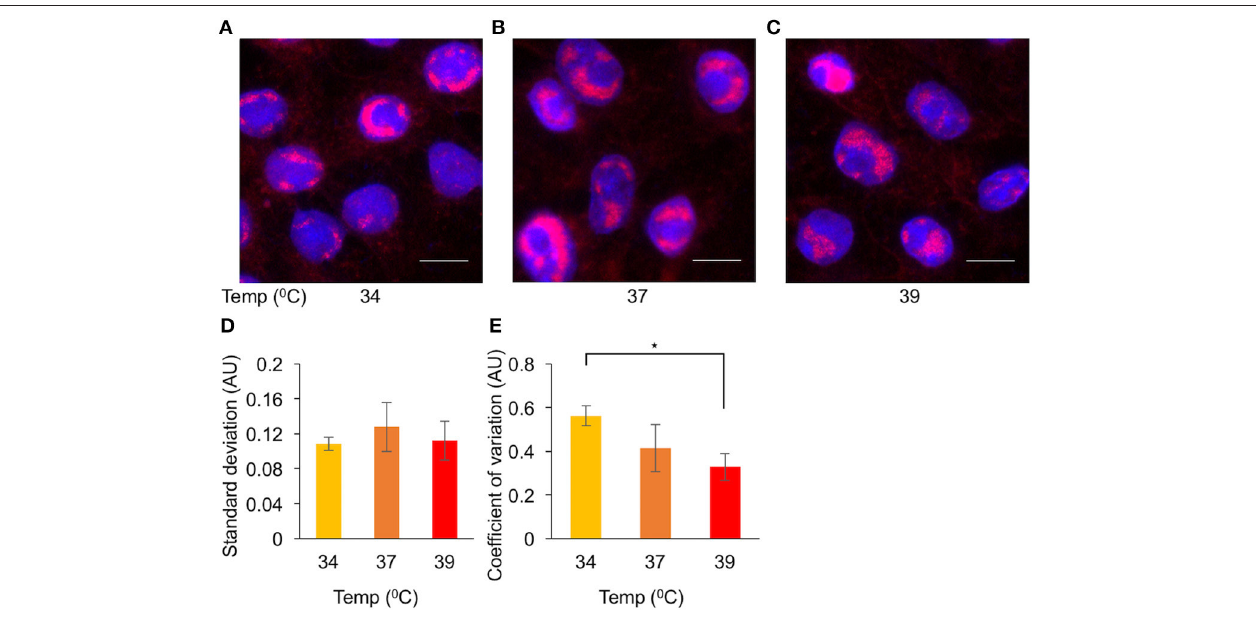
FIGURE 6 | Elevated temperature reduces cell-to-cell variability in replication compartments size. Cells were infected with OK11 recombinant virus at MOI 20. Four HPI the cells were fixed and processed for FISH. Representative images of infection at 34 ◦ C (A) , 37 ◦ C (B), and 39 ◦ C (C) are shown. Nuclei are colored with Hoechst stain in blue, viral DNA in red. Scale bar 10 µ m. (D,E) A noise comparison between the relative size of viral RCs at different temperatures, (as indicated) was performed. (D) The standard deviation and (E) the coefficient of variation (standard deviation divided by the mean) were compared. Error bars represent the standard error of the means among the different frames. * P < 0.05 by student T